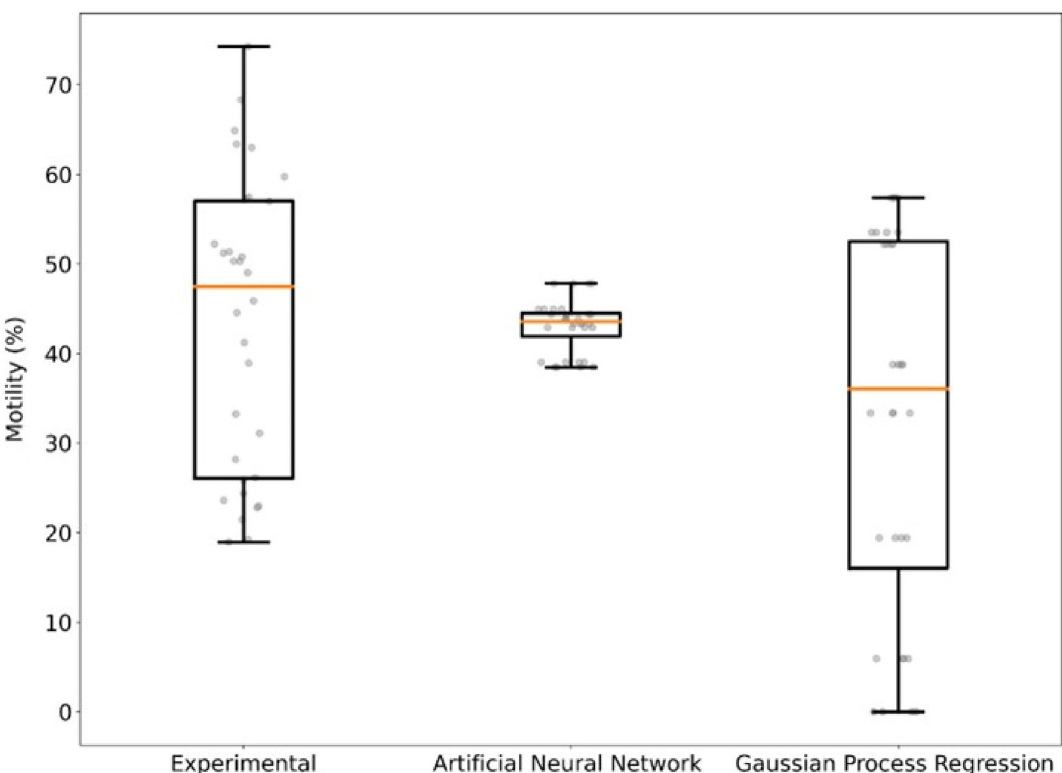
Figure 2. Experimental results and post-thaw motility predictions for Generation 6, where artificial neural network and Gaussian process regression models were trained using results from generation